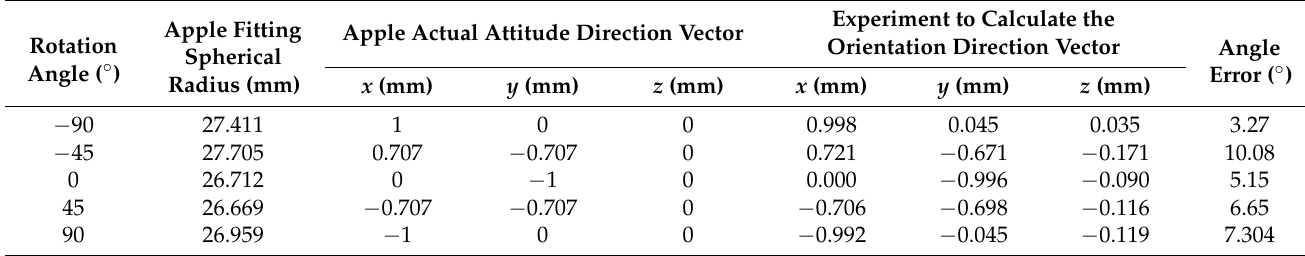
Table 3. Experimental data rotated around the z